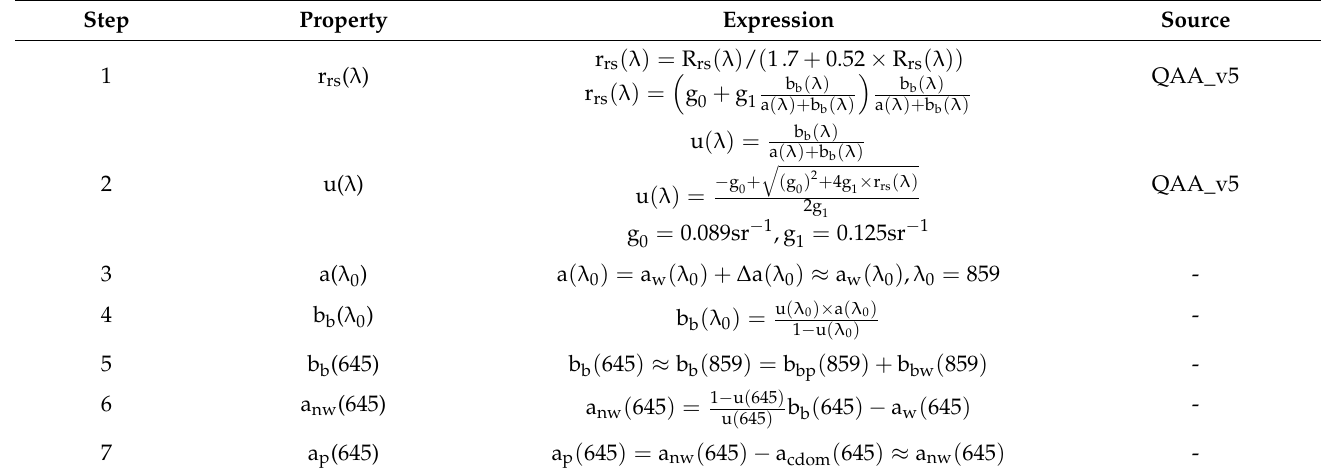
Table 1. Steps of QAA645-a p algorithm.